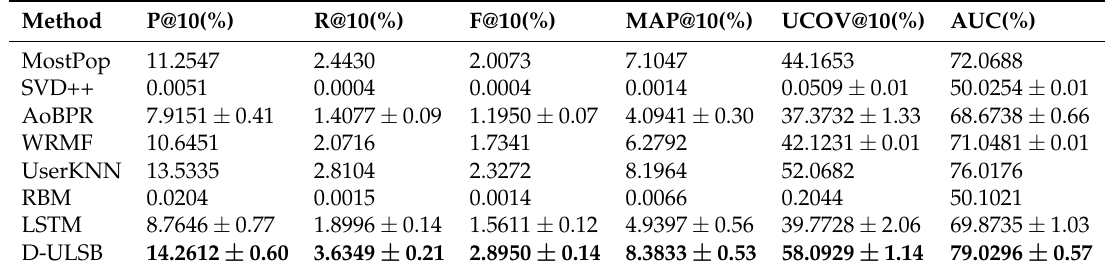
Table 6. Comparation between DTNMR and the seven baseline